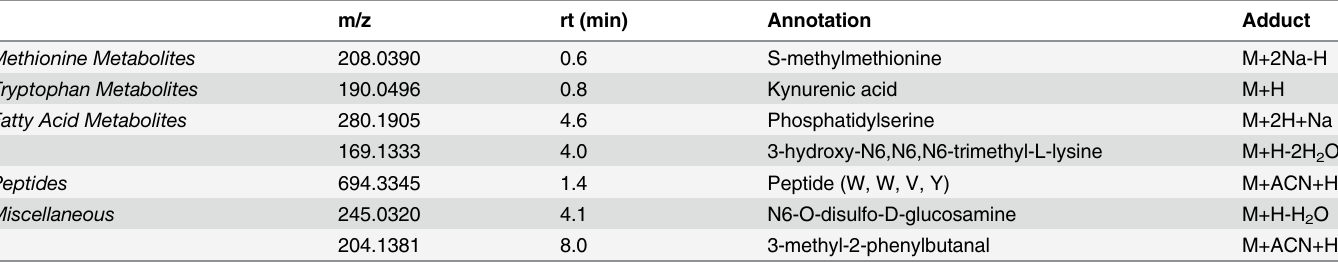
Table 3. Selected m/z features decreased in AUD